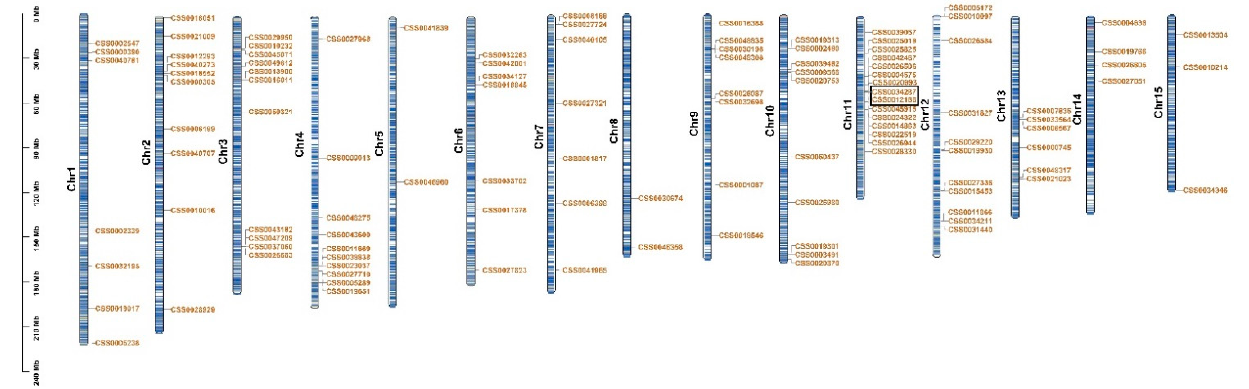
Figure 2. Chromosomal location of CsC2H2-ZFP genes in C. sinensis genome. The length of chromosomes is represented in Mb. Black lines within chromosomes indicate genes of C. sinensis . The number of chromosomes is presented at the left side of individual chromosomes. Genes of CsC2H2-ZFP are marked in red. Tandemly duplicated genes are marked with black boxes.